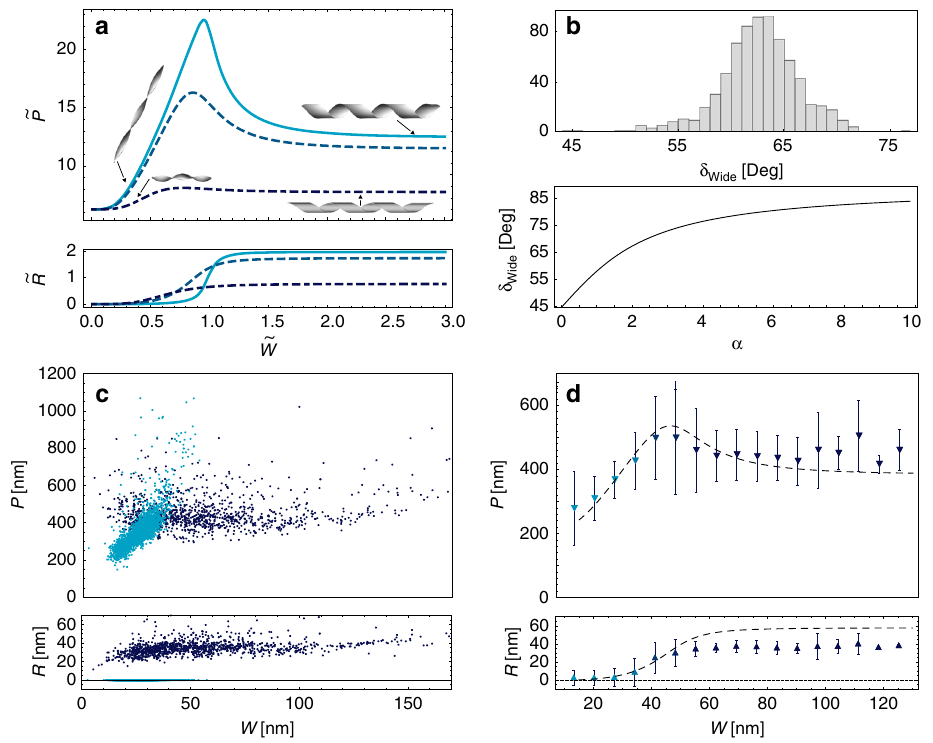
Fig. 3 Ribbon ’ s shape as a function of width. a Analytic solutions for the dimensionless ribbon-pitch, ~ P , and radius, ~ R , as functions of the dimensionless width, ~ W for different values of α (0.01 (solid cyan), 0.1 (dashed light blue), and 1 (dot-dashed dark blue)). As α increases, the twist-to-helical transition becomes smoother and occurs earlier. Insets show selected realizations of ribbon con fi gurations. b Top: the distribution of the measured pitch angle of wide ( W > 80 nm) ribbons. Bottom: the computed pitch angle of wide ribbons ( ~ W ! 1 ), δ (bottom) vs. W . Cyan data points mark twisted ribbons ( R = 0) and blue points indicate helical ribbons ( R > 0). The pitch increases in the twisted phase, then slightly decreases, beyond the twisted-to-helical transition, and then both pitch and radius are stabilized on roughly constant values. Measurement error is typically ±6 nm for P and ±4 nm for R . Note the large asymmetric scatter in the pitch near the twisted-to-helical transition at W ≈ 40 nm. d The average (over Δ W = 2 nm) of the data in c vs. W , together with the solutions for Eqs. (1) and (2) with k Poisson ’ s ratio v = 0.5. The experimental data is colored by the relative abundance of twisted (cyan) and helical (blue) ribbons at a given width. Error bars indicate